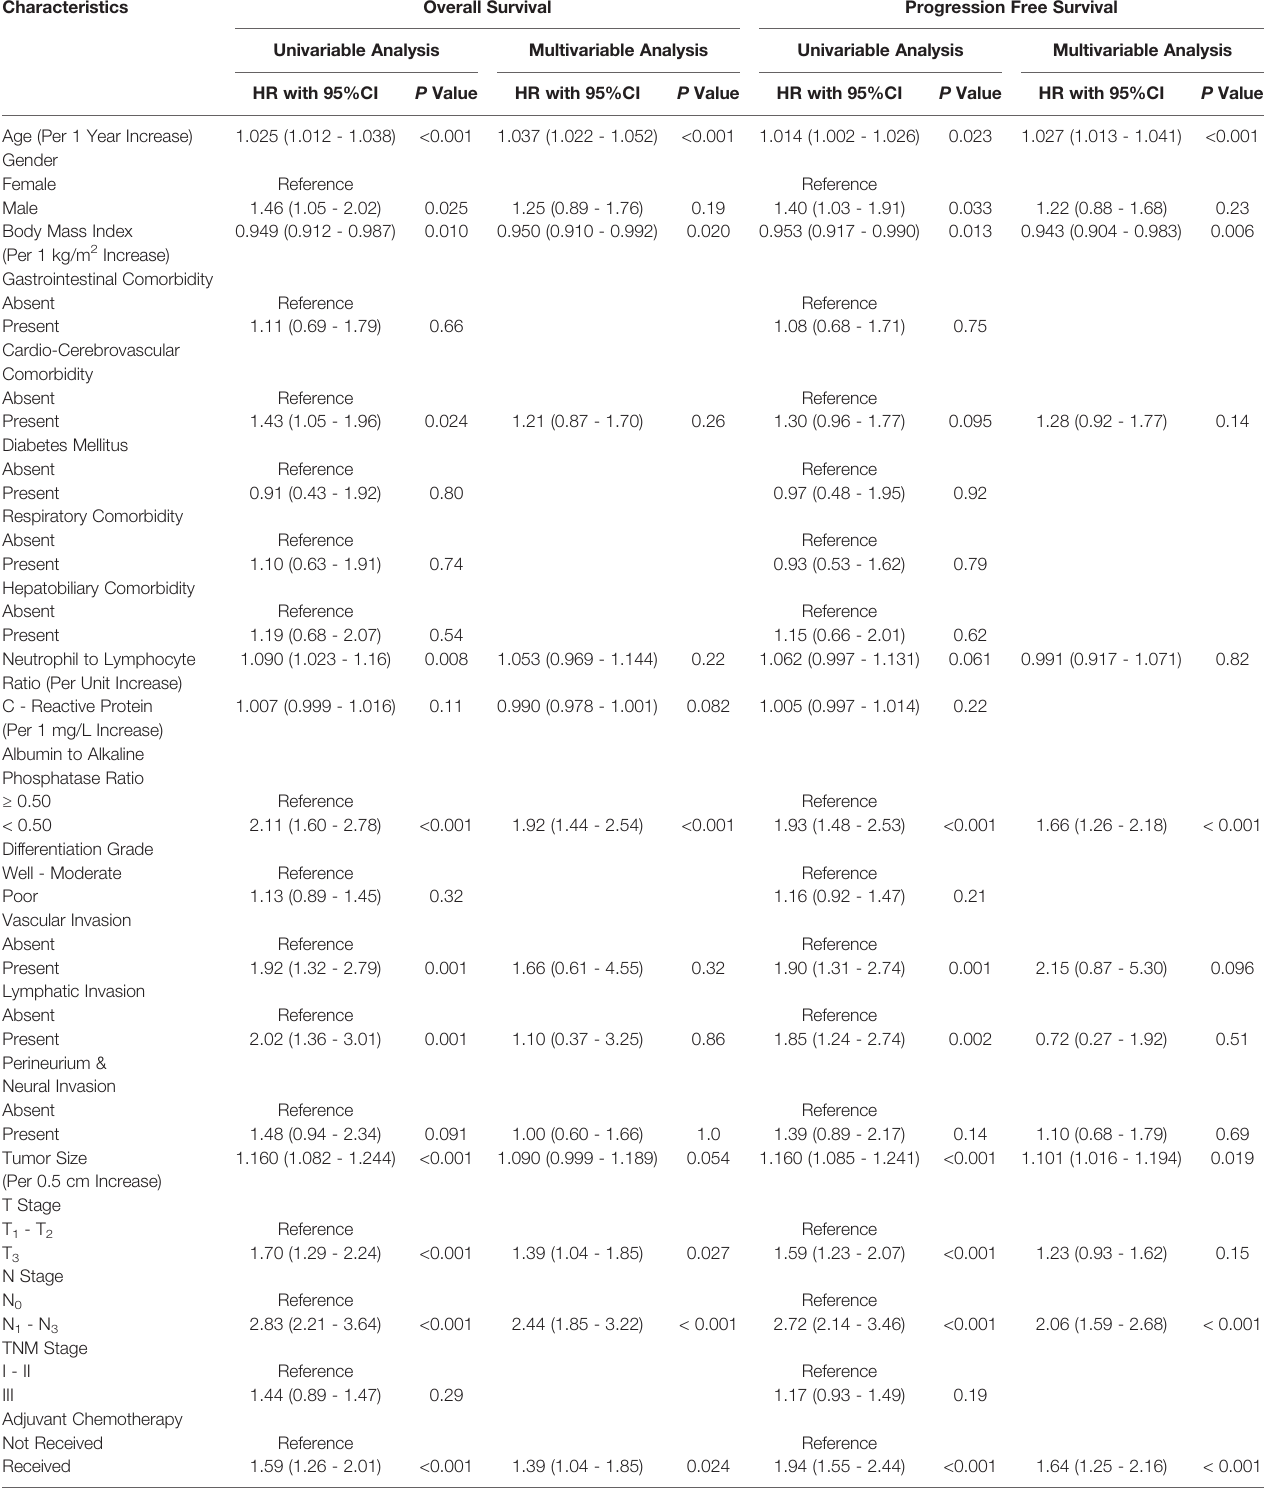
TABLE 2 | Univariable and multivariable analyses of the prognostic factors in the entire cohort.